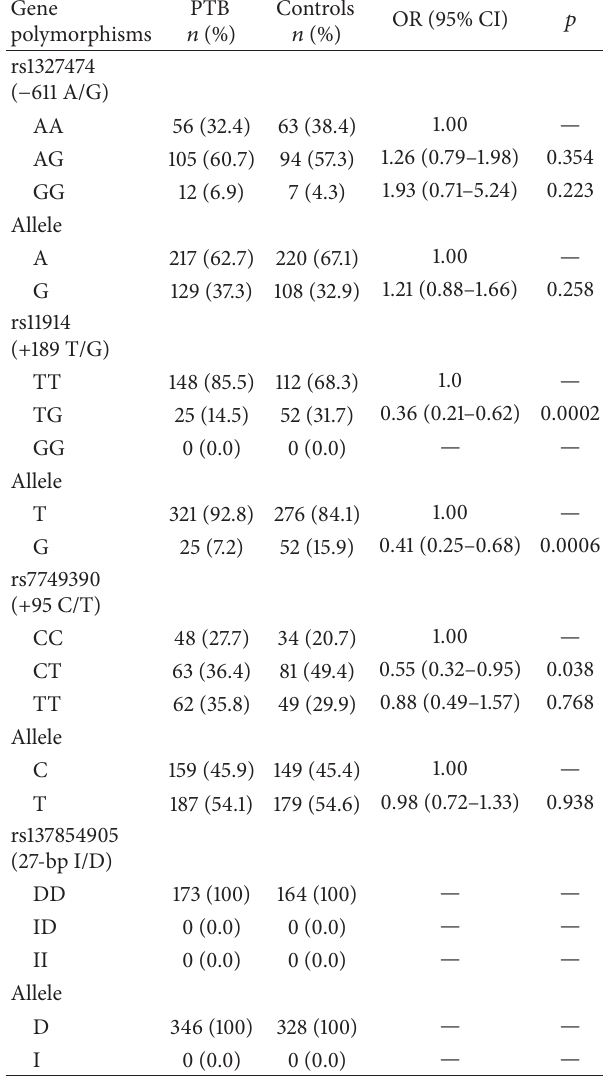
Table 2: Frequency distribution of INFGR1 gene polymorphisms in PTB and control